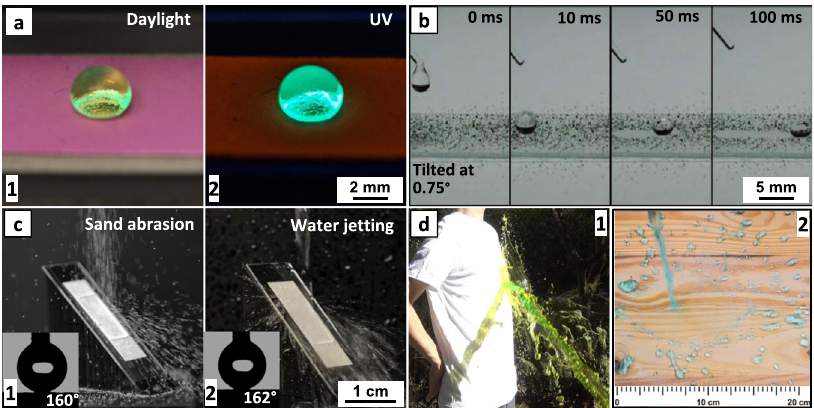
Fig. 4 Encapsulation capability and real-life applicability of the superhydrophobic coating. a A drop of dye (pyranine) solution on a superhydrophobic fi lter paper surface encapsulated with a luminescent chromophore (Rhodamine B) under daylight ( a -1) and UV lamp illumination ( a -2); b demonstration of the self-cleaning property on a treated glass slide; c mechanical stability test of modi fi ed glass slides with sand abrasion ( c -1) and water jetting ( c -2) experiments; the insets show water contact angles measured on the surface after the tests; d side view of water splashed off from the treated, superhydrophobic cotton T-shirt ( d -1); water splashing test on a large piece of pine wood modi fi ed with the spray method ( d